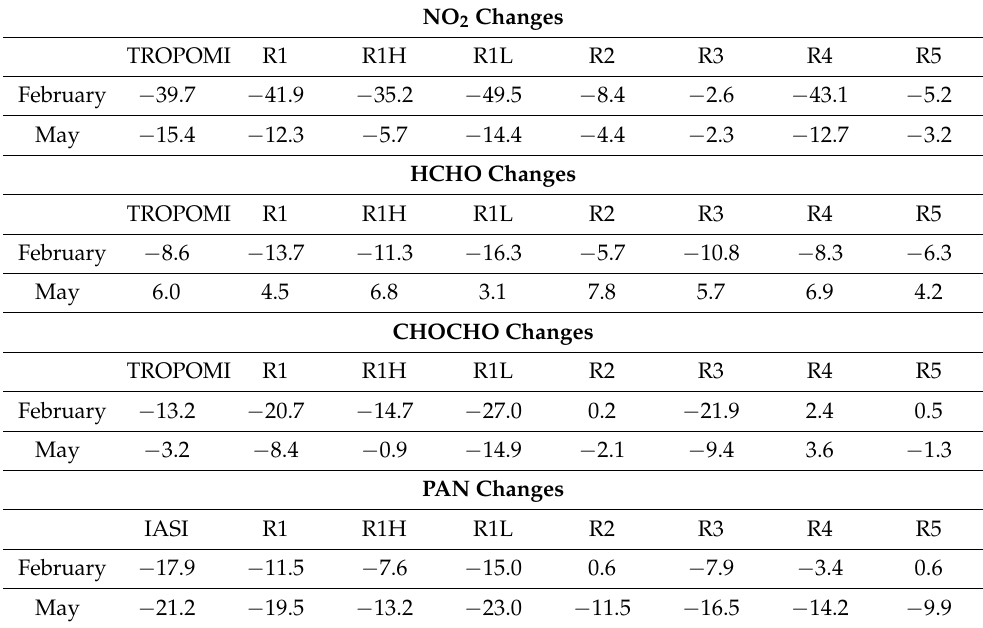
Table 2. Percentage changes of monthly columns between 2020 and the same month in 2019 ((2020-2019)/2019), based on observed and modelled columns from simulations R1 (CONFORM emissions), R1H and R1L (high and low CONFORM emissions), R2 (baseline emissions), R3 (fixed anthropogenic NOx flux), R4 (fixed anthropogenic VOC flux), and R5 (fixed anthropogenic and natural fluxes). All values are calculated for the eastern China region shown in Figure 4 delimited by 22–42 ◦ N, 108–125 ◦